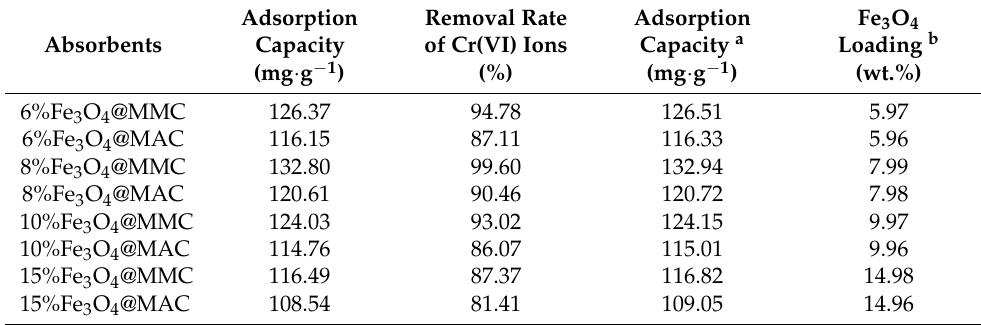
Table 5. The adsorption performance by different